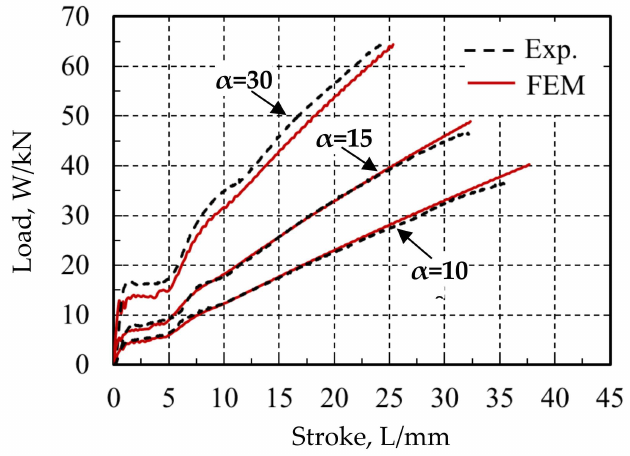
Figure 2. Load–stroke curves in FEM simulation (FEM) and experiment (Exp.) of flaring test with different conical tools.